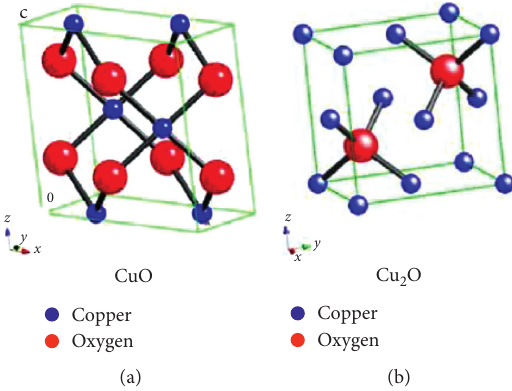
Figure 1: The structure of the molecule Cu